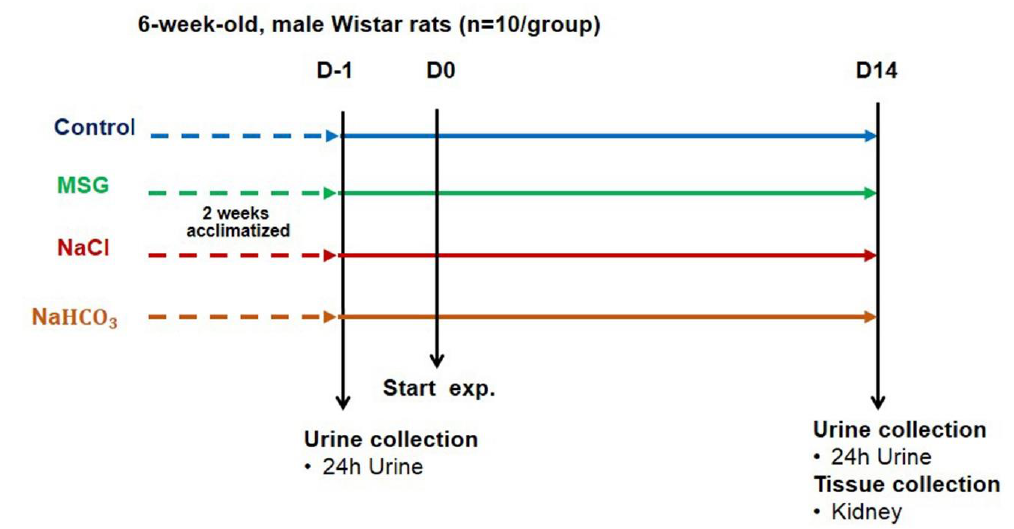
Figure 1. A schematic diagram showing the experimental design and sample collection.